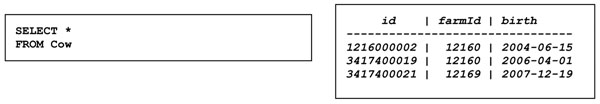
Query to get all columns and rows of the Cow table